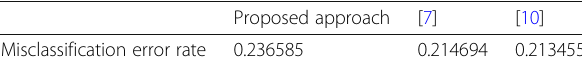
Table 2 Misclassification error rate for manually tampered images